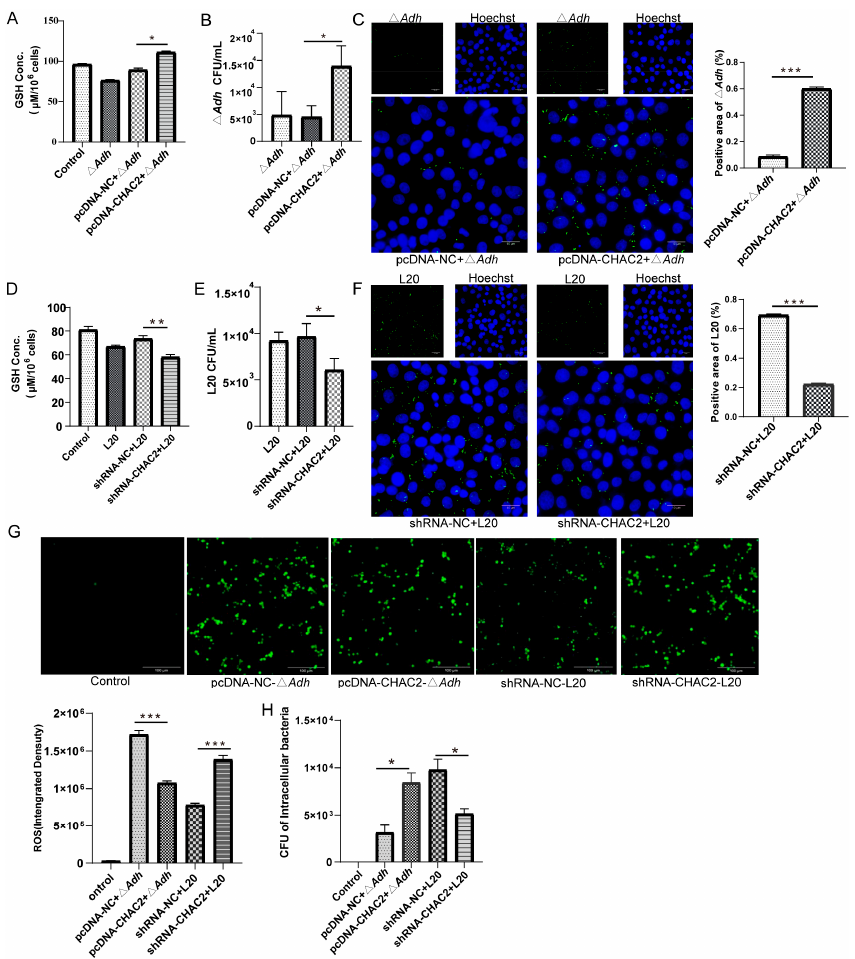
Figure 3. CHAC2 overexpression or suppression altered GSH, ROS, and intracellular bacterial counts during A. pleuropneumoniae infection. ( A , B ) Effects of treatment with pcDNA-CHAC2 on ( A ) GSH levels and ( B ) intracellular bacterial counts in PAM treated with Δ Adh . ( C ) Intracellular bacterial counts in Δ Adh by Immunofluorescence. ( D , E ) Effects of treatment with shRNA-CHAC2 on ( D ) GSH levels and ( E ) intracellular bacterial counts in PAM treated with A. pleuropneumoniae strain L20. ( F ) Intracellular bacterial counts in A. pleuropneumoniae strain L20 by Immunofluorescence. ( G , H ) Effects of treatment with CHAC2 overexpression or inhibitor on ( G ) ROS levels (ImageJ analysis) and ( H ) intracellular bacterial counts in PAM treated with A. pleuropneumoniae ( ∆ Adh or L20). t -test and One-way ANOVA. * p < 0.05, ** p < 0.01, and *** p < 0.001. 3.4. CHAC2 Inhibits Inflammatory Cytokine Expression by NOD1/NF- κ B Signaling Path Way during A. pleuropneumoniae Infection To dissect the function of CHAC2 in inflammation during A. pleuropneumoniae infection, PAM transfected with or without CHAC2 knockdown and overexpression vectors were exposed to A. pleuropneumoniae strain L20 to measure the expression levels of inflammatory cytokines. The qRT-PCR cytokine detection results showed that silencing of CHAC2 aggravated the A. pleuropneumoniae- induced expression of proinflammatory factors IL-1 β , IL-6 , and TNF- α , while overexpression of CHAC2 blunted these cytokines expression (Figure 4A–C). Meanwhile, Western blot results showed that CHAC2 knockdown significantly increased the expression of activated NOD1 and NF- κ B (Figure 4D,E). In addition, the presence of the selective NOD1/NF- κ B inhibitor ML130 abolished the proinflammatory effect of CHAC2 deletion during A. pleuropneumoniae treatment (Figure 4A–E). These results indicated the regulatory role of CHAC2 in inflammation